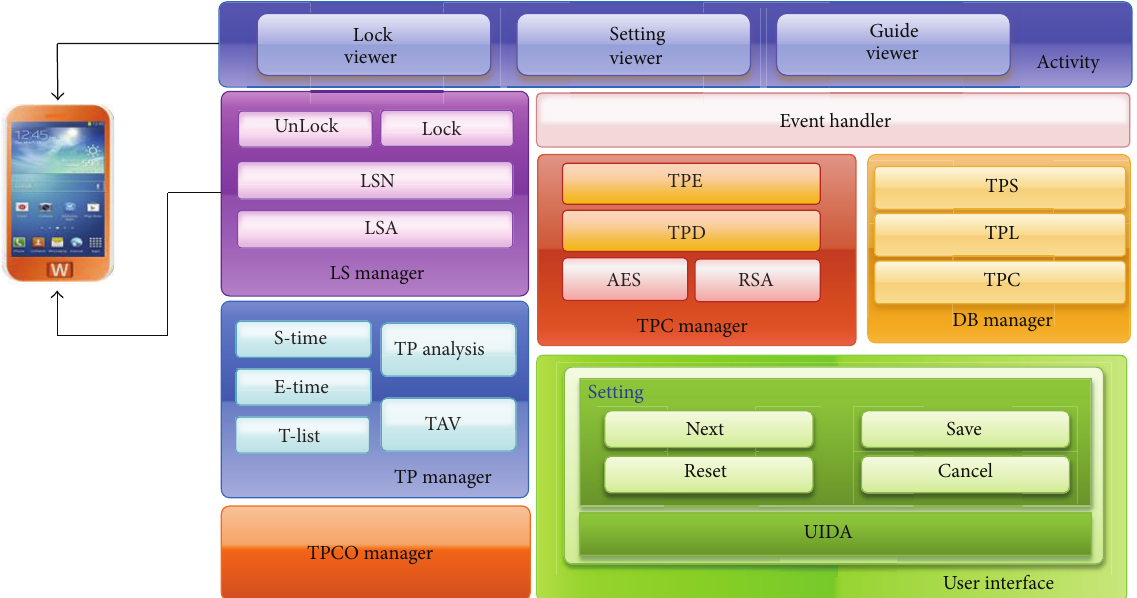
Figure 3: Overall architecture of SLSTP module structure for locking multimedia